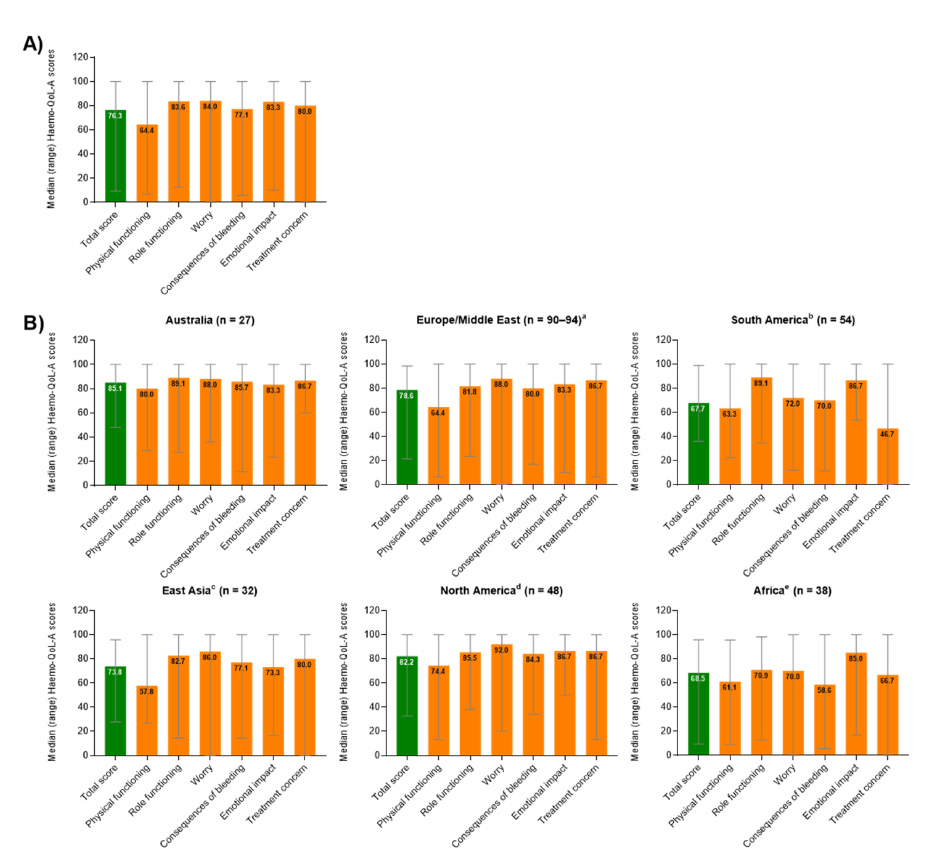
Figure 2. Median (range) overall transformed Haemo-QoL-A total and domain scores at baseline ( A ) for all participants globally ( n = 298) and ( B ) for participants by region. Haemo-QoL-A scores range from 0 to 100, with higher scores indicat- ing higher quality of life. a Belgium, Germany, Spain, France, UK, Israel, and Italy. For total score, n = 90; Physical func- tioning, n = 94; Role functioning, n = 94; Worry, n = 91; Consequences of bleeding, n = 93; Emotional impact, n = 91; Treat- ment concern, n = 94. b Brazil. c Korea and Taiwan. d US. e South Africa. Haemo-QoL-A, haemophilia-specific health-related quality of life questionnaire for adults; SD, standard deviation.